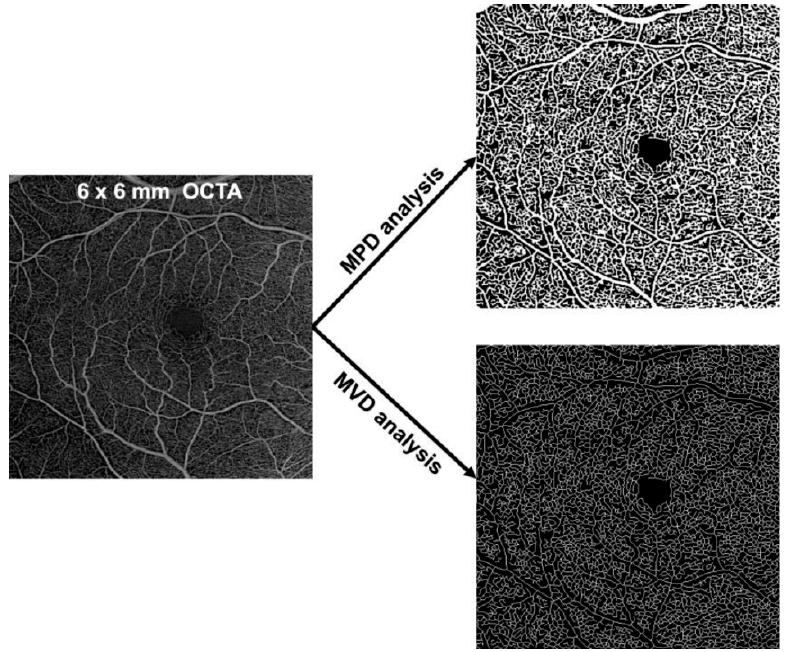
Figure 1. Post-acquisition analysis. MPD: mean perfusion density; MVD: mean vascular density.